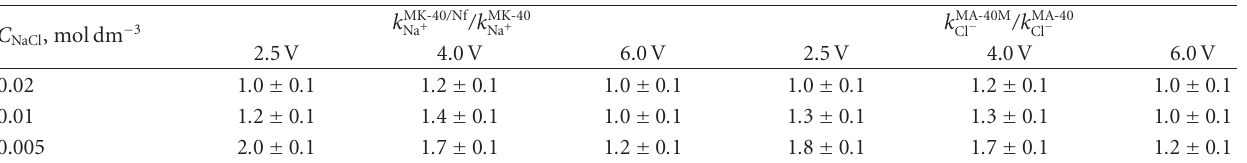
Table 2: Ratio of Na + to Cl − mass-transfer coe ffi cients for ED cells with modified and commercial membranes at di ff erent feed solution concentrations and potential drops per cell.